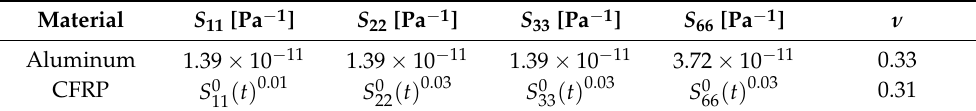
Table 1. Material properties for aluminum 7075-T6 [29] and viscoelastic equations for CFRP [30] used in the present study.